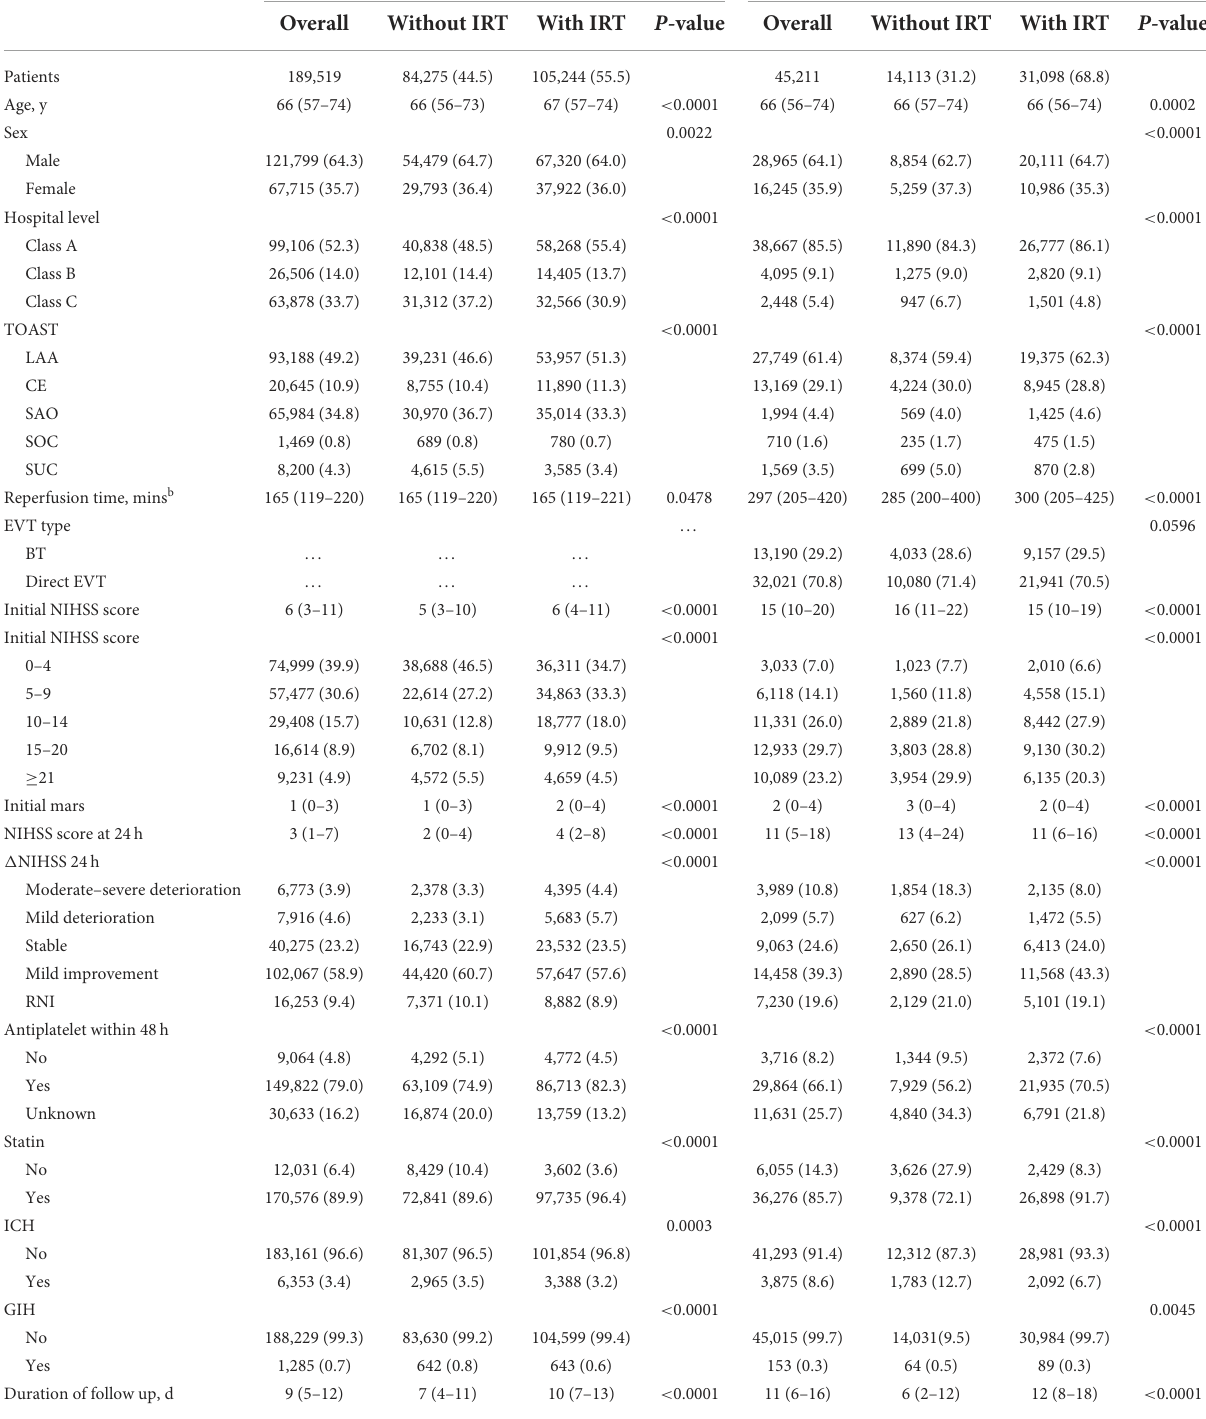
TABLE 1 Demographic and clinical characteristics of patients with thrombolysis only and endovascular therapy. Thrombolysis-only group a Endovascular therapy group a Overall Without IRT With IRT P -value Overall Without IRT With